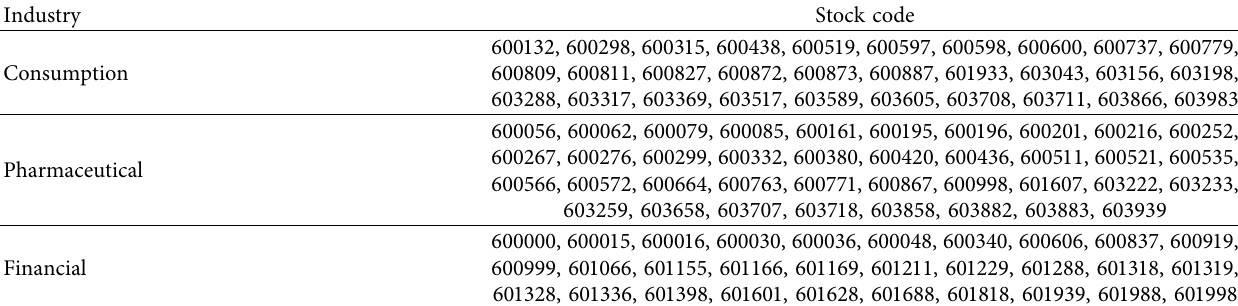
Table 1: Description of 98 stocks in the consumption, pharmaceutical, and fnancial industries. Industry Stock